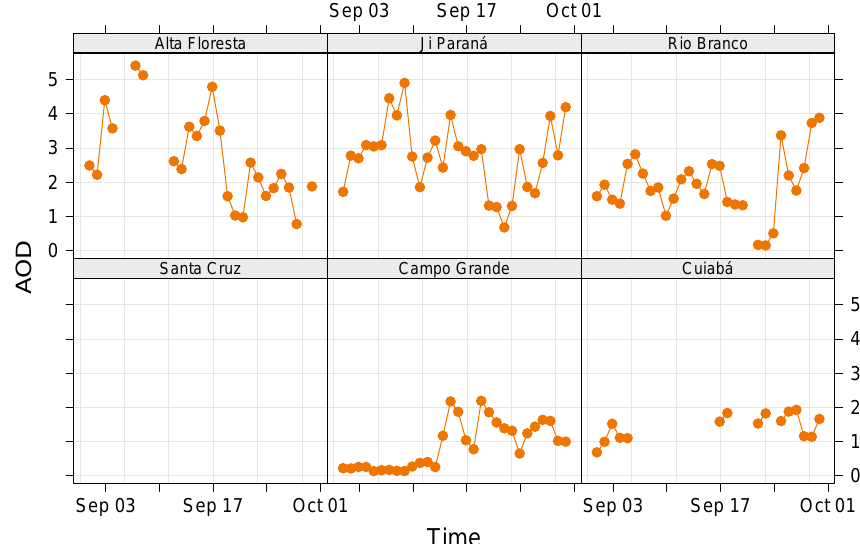
Fig. 4. Daily AOD during September 2007 from the AERONET stations. There were no measurements from the Santa Cruz station for this